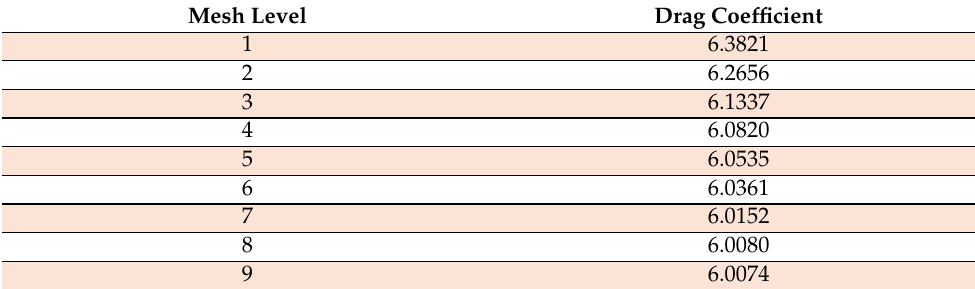
Table 2. Drag coefficient data for Case-I with PVP.